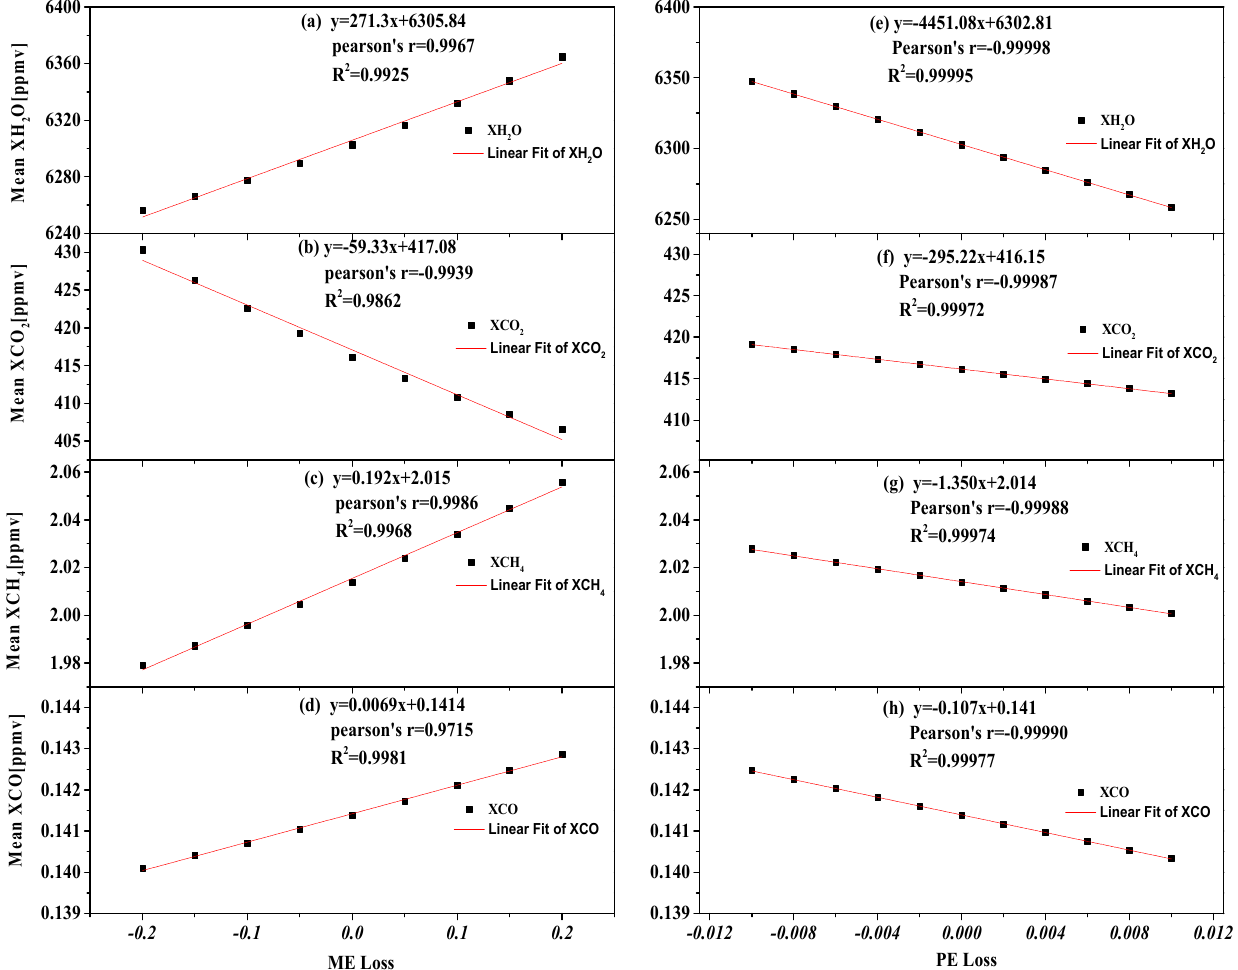
Figure 3. Influence of the modulation efficiency amplitudes and phase errors on XH 2 O, XCO 2 , XCH 4, and XCO with the reference standard instrument.